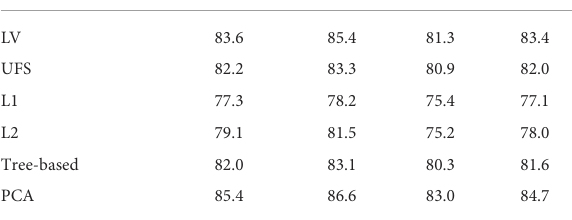
TABLE 3 LR prediction result of feature selection method on balanced dataset.